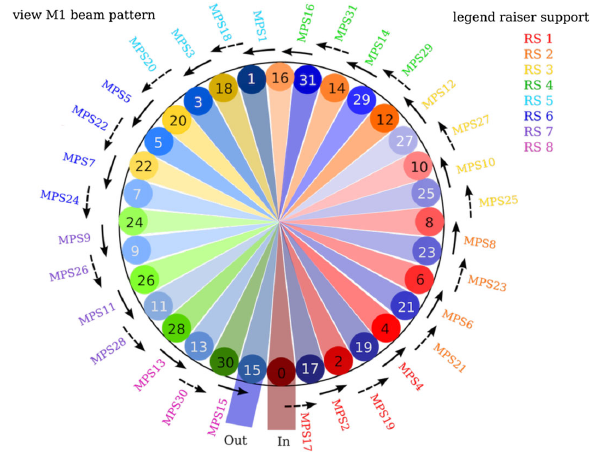
FIG. 20. Schematic view of the laser beam circulation on the M1 parabolas seen from the IP point. The RS j are the support of the MPS and injection/ejection mirror pairs, indexed in colors, and the arrow represent the MPS. 4 MPS are mounted on each raising support block except for the first and the last ones where the injection and ejection mirrors are fixed